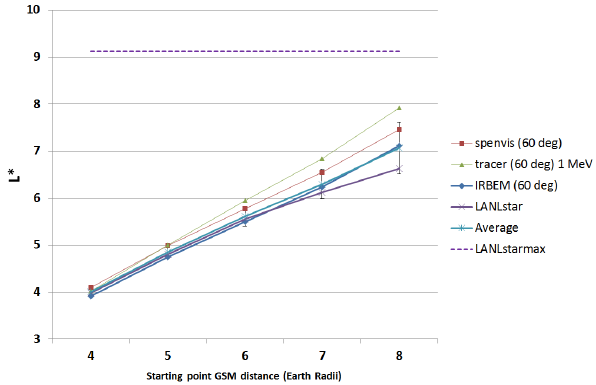
Figure 5. Calculations of L ∗ as a function of initial distance (in R E ) at 00:00MLT, for an initial pitch angle of 60 ◦ during quiet solar wind conditions. Error bars represent the standard deviation between results from the various